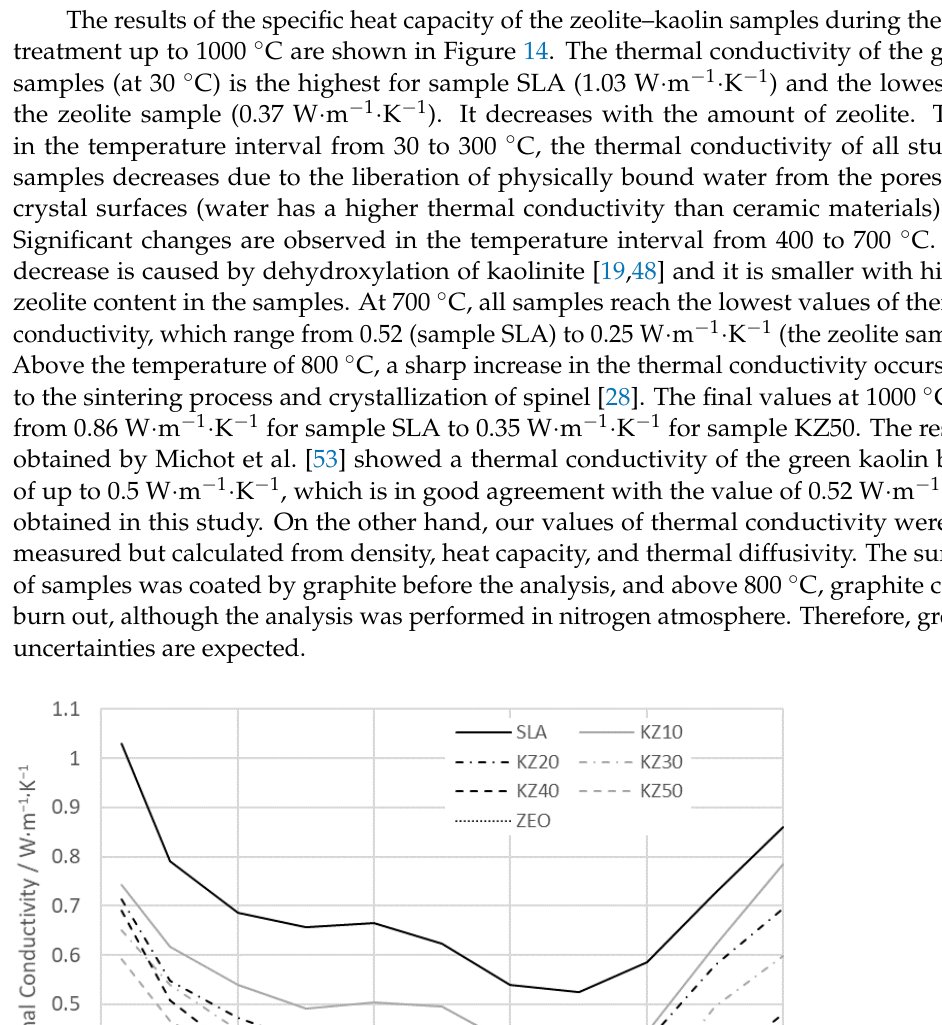
Figure 13. Specific heat capacity of the studied samples at 800, 900, and 1000 °C.